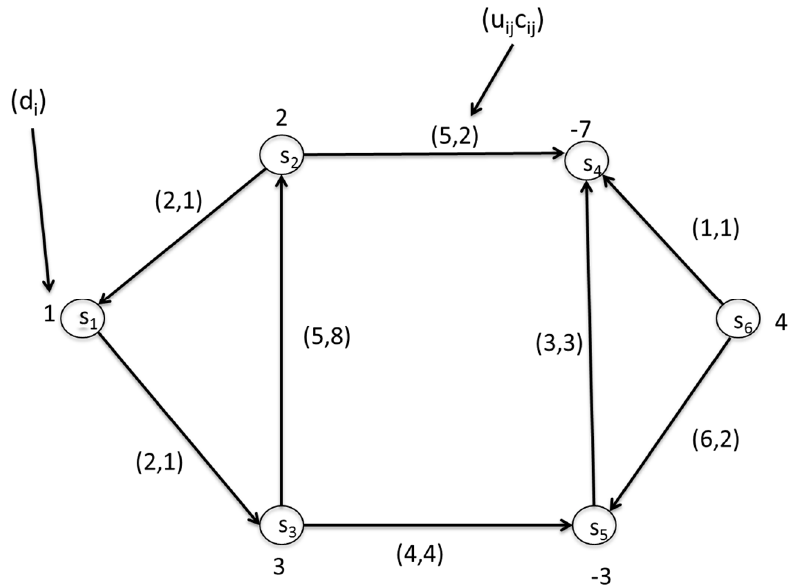
Figure 5. WSN graph representation.